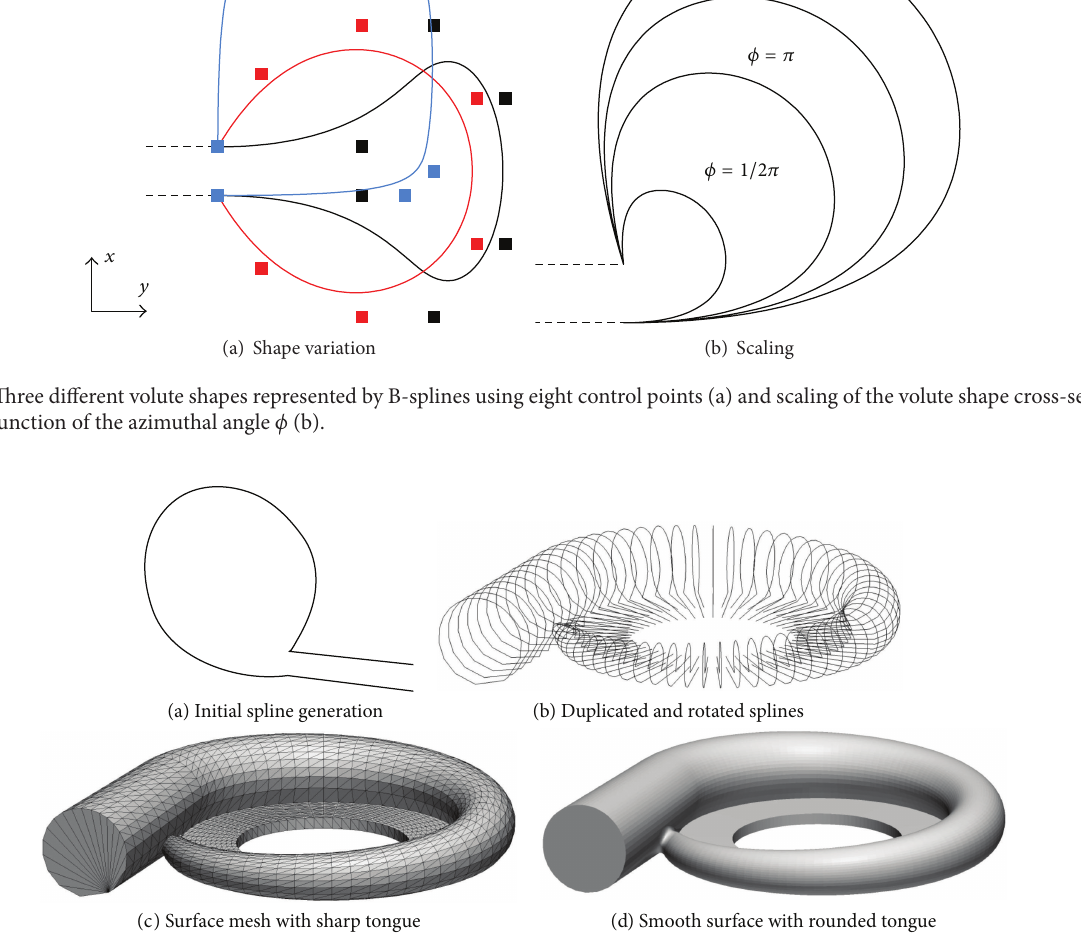
Figure 6: Steps of volute geometry. The surface mesh and spline representation are simplified for better